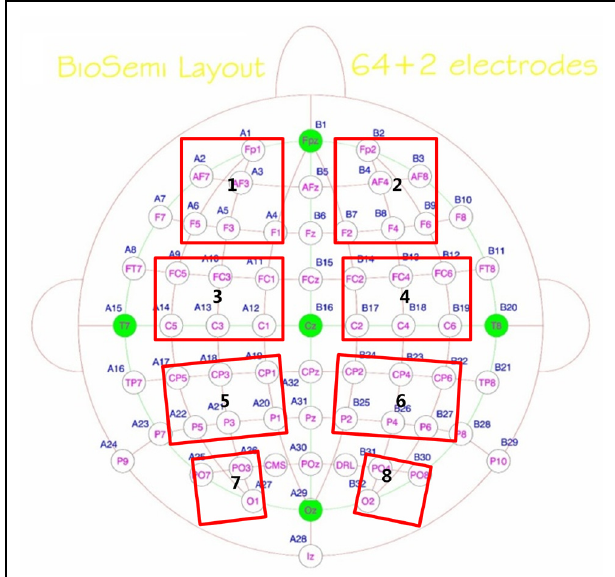
FIGURE 2 | Eight regions of interest (ROIs, marked by red rectangles) for inter-region analysis were selected including left prefrontal (Fp1, AF7, AF3, F5, F3, F1), right prefrontal (Fp2, AF8, AF4, F6, F4, F2), Left central-frontal (FC5, FC3, FC1, C5, C3, C1), right central-frontal (FC6, FC4, FC2, C6, C4, C2), Left central-parietal (CP5, CP3, CP1, P5, P3, P1), right central-parietal (CP6, CP4, CP2, P6, P4, P2), Left parietal-occipital (PO7, PO3, O1), and right parieto-occipital (PO8, PO4, O2) regions.